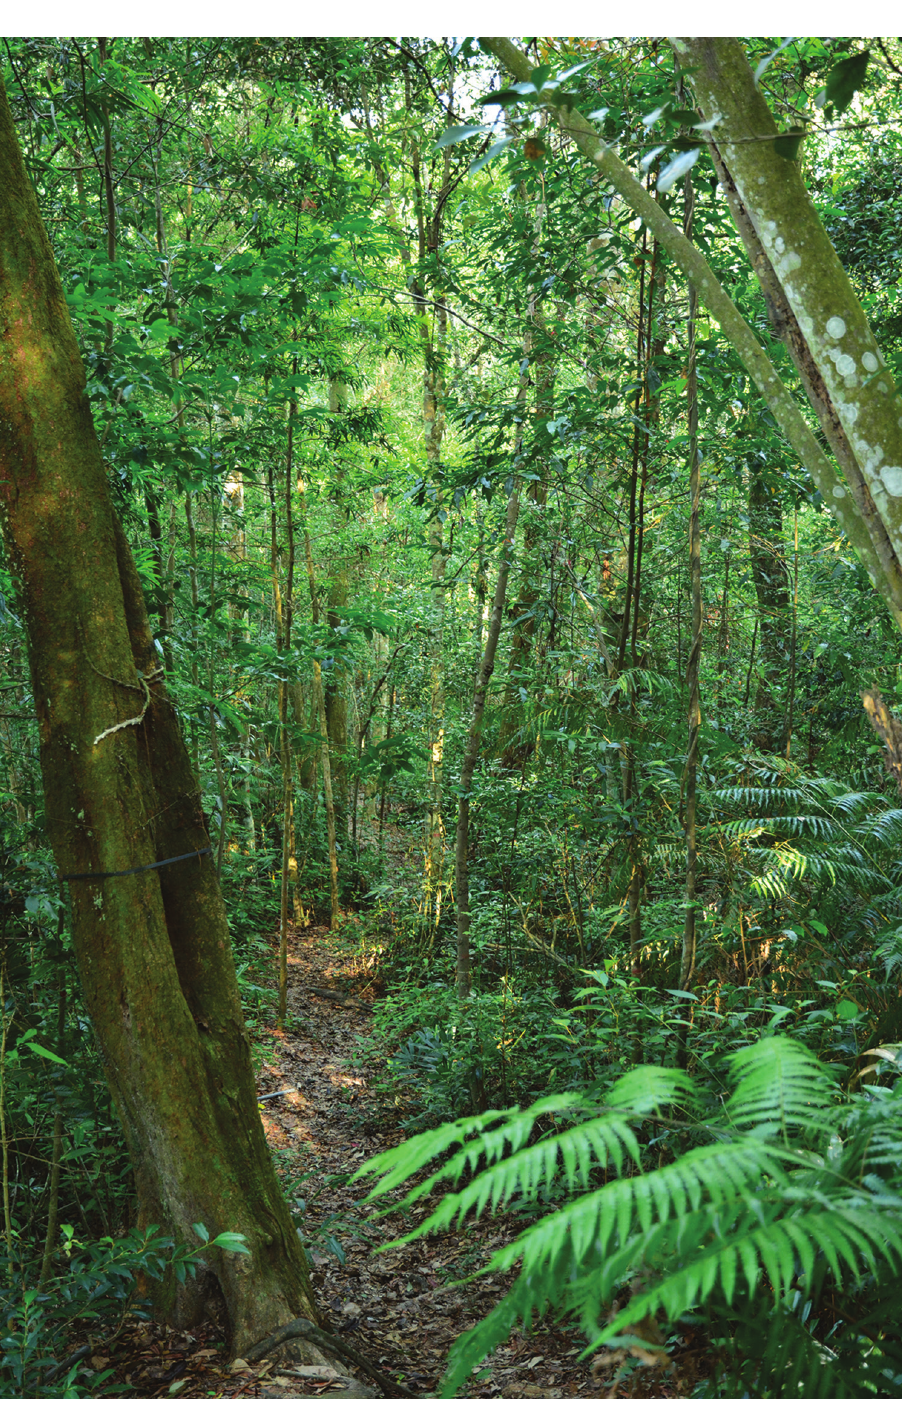
Figure 5. Photograph of the subtropical evergreen broad-leaved forest in the Lienhuachih Forest Dy- namics Plot, Nantou County,